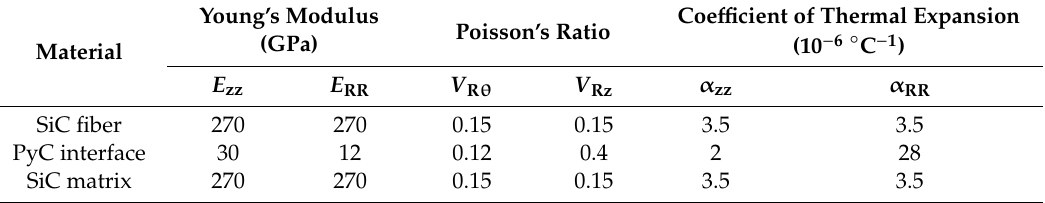
Figure 5. Sketch of SiC–SiC FEM model. Table 4. Mechanical parameters used in the finite element calculation of residual stress [21,23].